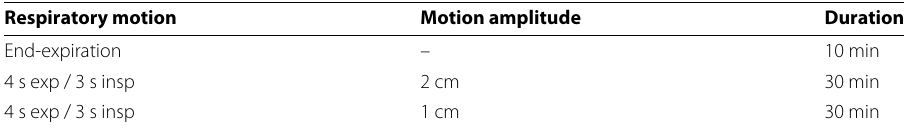
Respiratory motion Motion